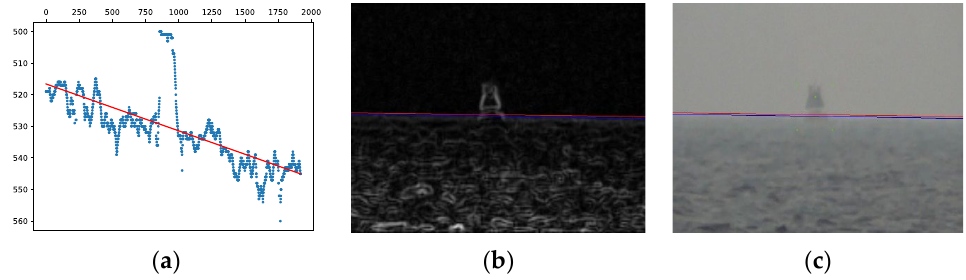
Figure 10. Image results of secondary sea-sky line extraction: ( a ) scatter fitting result; ( b ) secondary